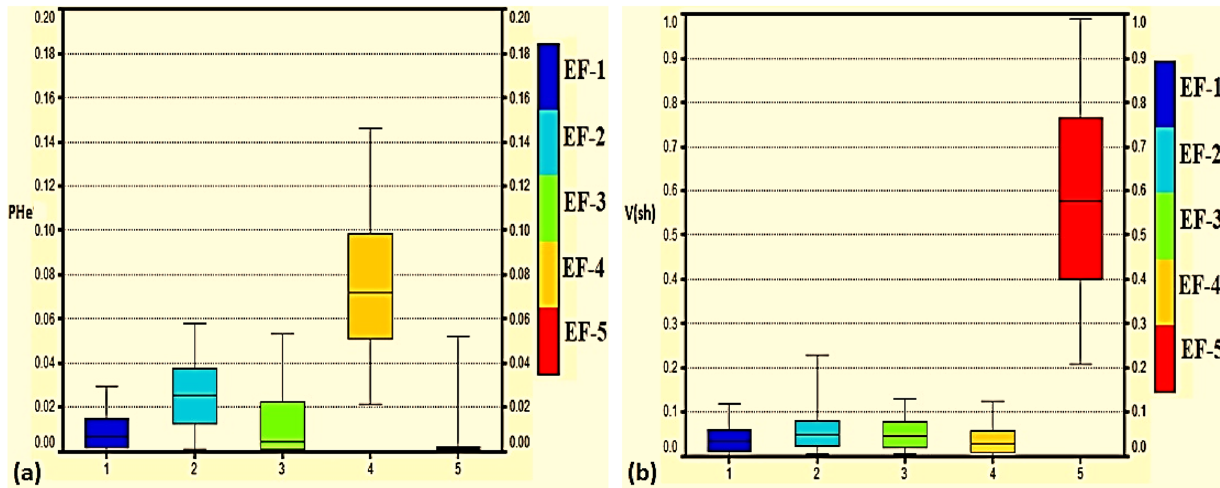
Fig. 8 a Boxplots of the effective porosity for Dalan and Kangan formations and b Boxplots of the shale volumes for Dalan and Kangan forma- tions